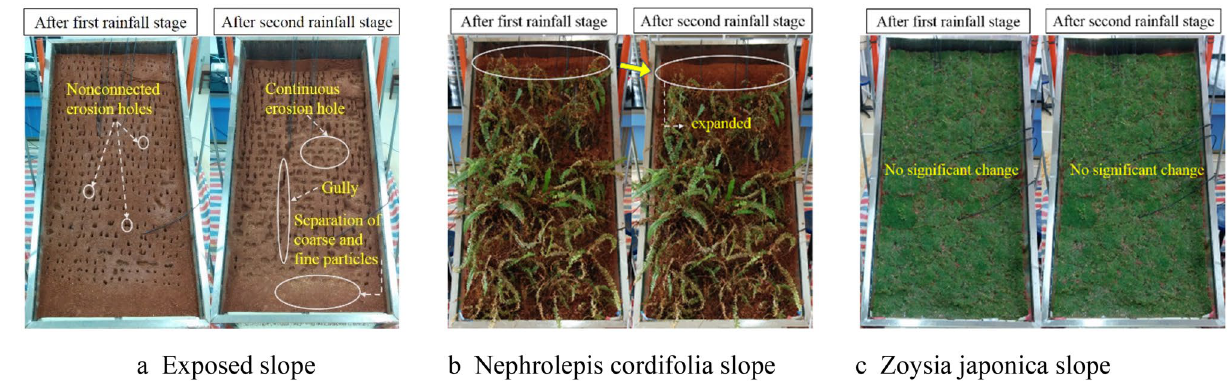
Figure 3. Comparison of the slope surfaces at the end of the rainfall